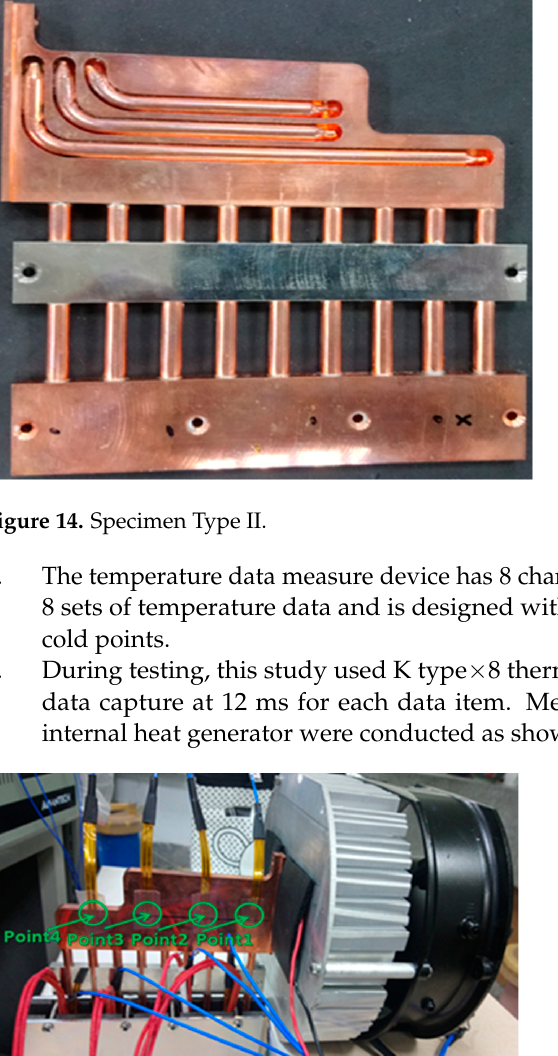
Figure 15. Measurement configuration diagram.